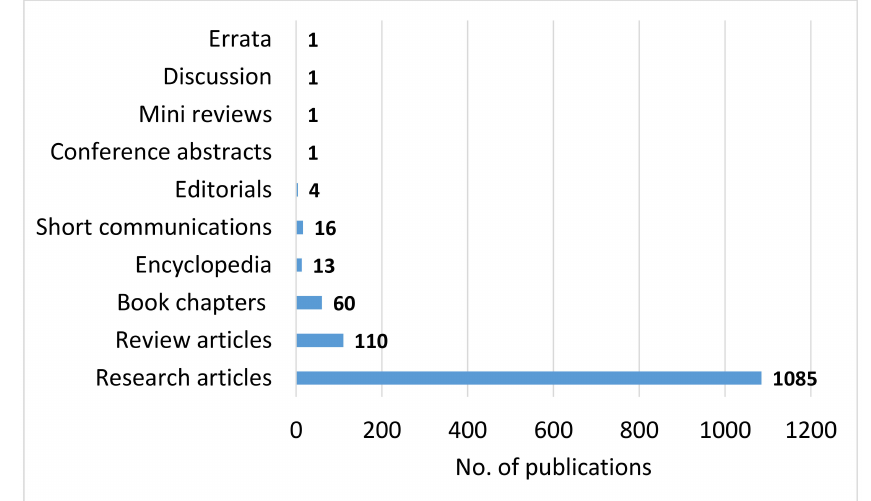
Figure 3. Number of articles for the main types of publications.